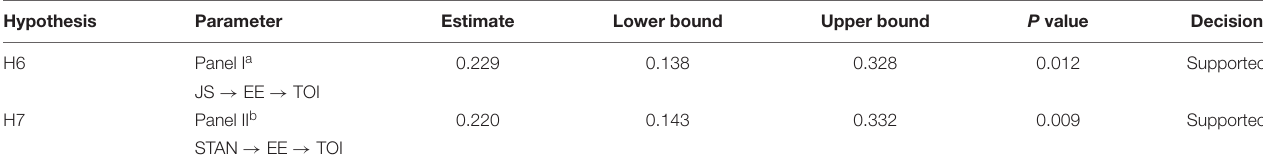
TABLE 6 | Standardized mediation effects: Parameter estimate and bootstrap percentile method confidence intervals.